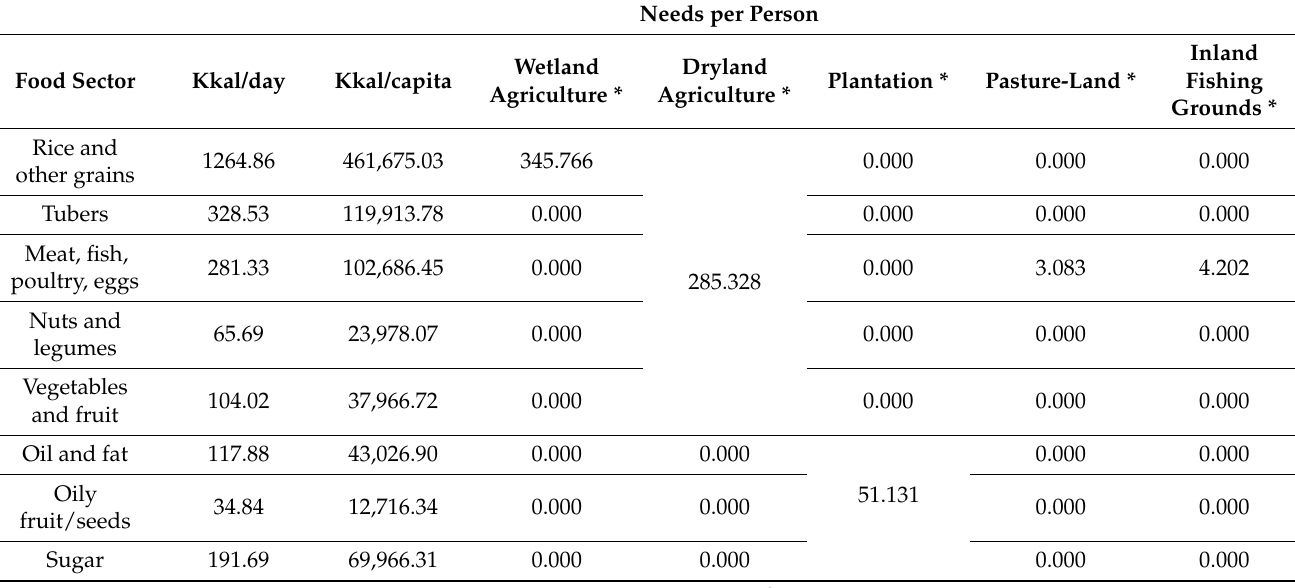
Table 4. Ecological footprint or land demand per person of the food sector in Java Island.